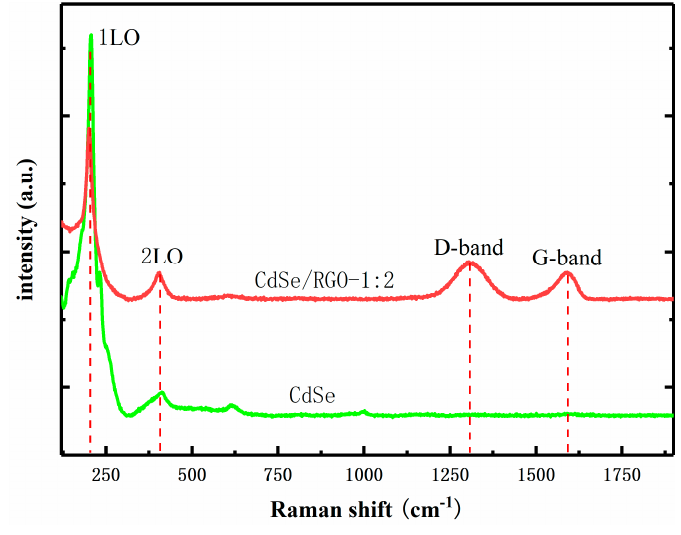
Figure 7. Raman spectra of CdSe and CdSe/RGO-1:2 composite materials.